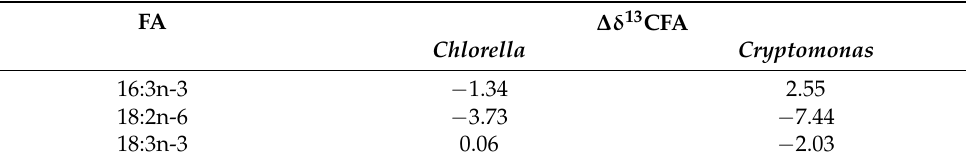
Table 1. Fractionation coefficients Δδ 13 CFA (‰) for the common essential dietary FAs selected for the isotope mixing model.